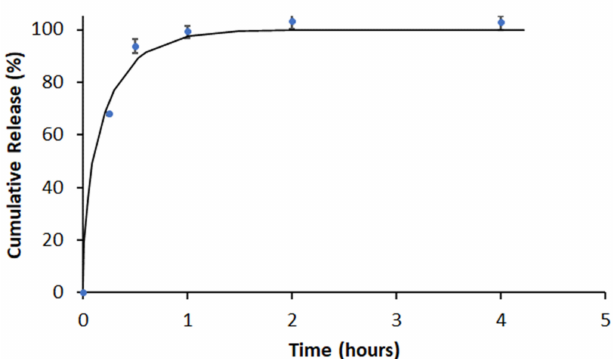
Figure 8. Flavopiridol released at designated times after soaking particles in 1X PBS with 0.2% ( v / v ) Tween-20 at 37 ◦ C (blue dots). In each time point of the measurement, the result is expressed as mean ± SD from n = 3 independent batches of ILDF microparticles. Nonlinear least-square fitting of the release profile using Equation (5) is shown as the solid black line.